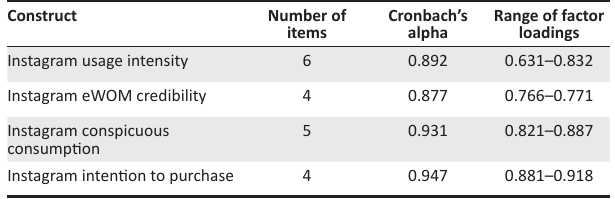
TABLE 1: Summary of reliability and validity analysis.